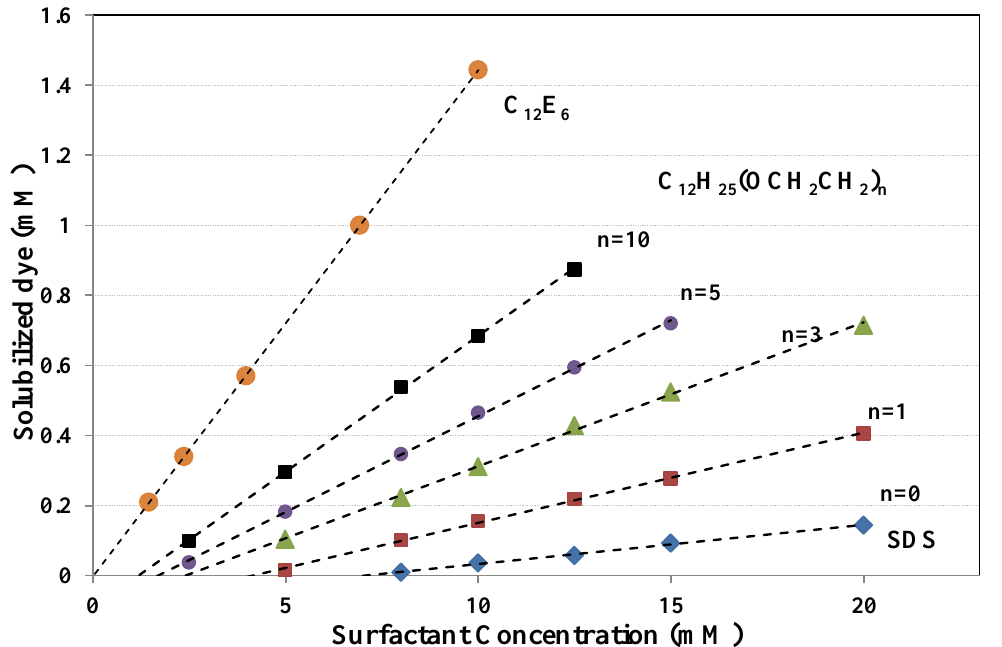
E is the nonionic surfactant and SDS stands for 12 6 H (OCH CH ) OSO 3− Na + with n = 0. 12 25 2 2 n